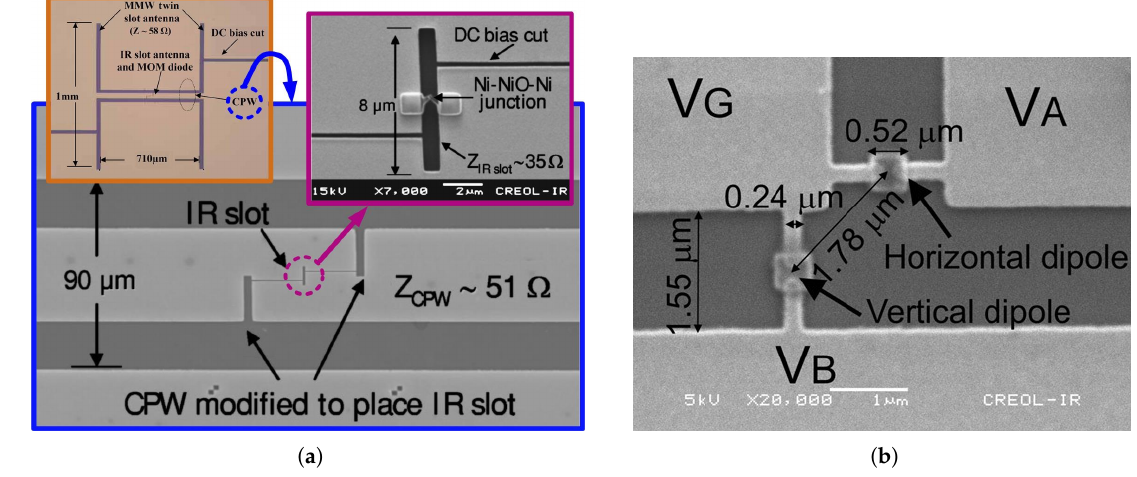
Figure 6. Dual antenna structures: ( a ) MMW/IR dual band antenna [48], ( b ) Orthogonal dipole antenna for elimination of cross polarization response